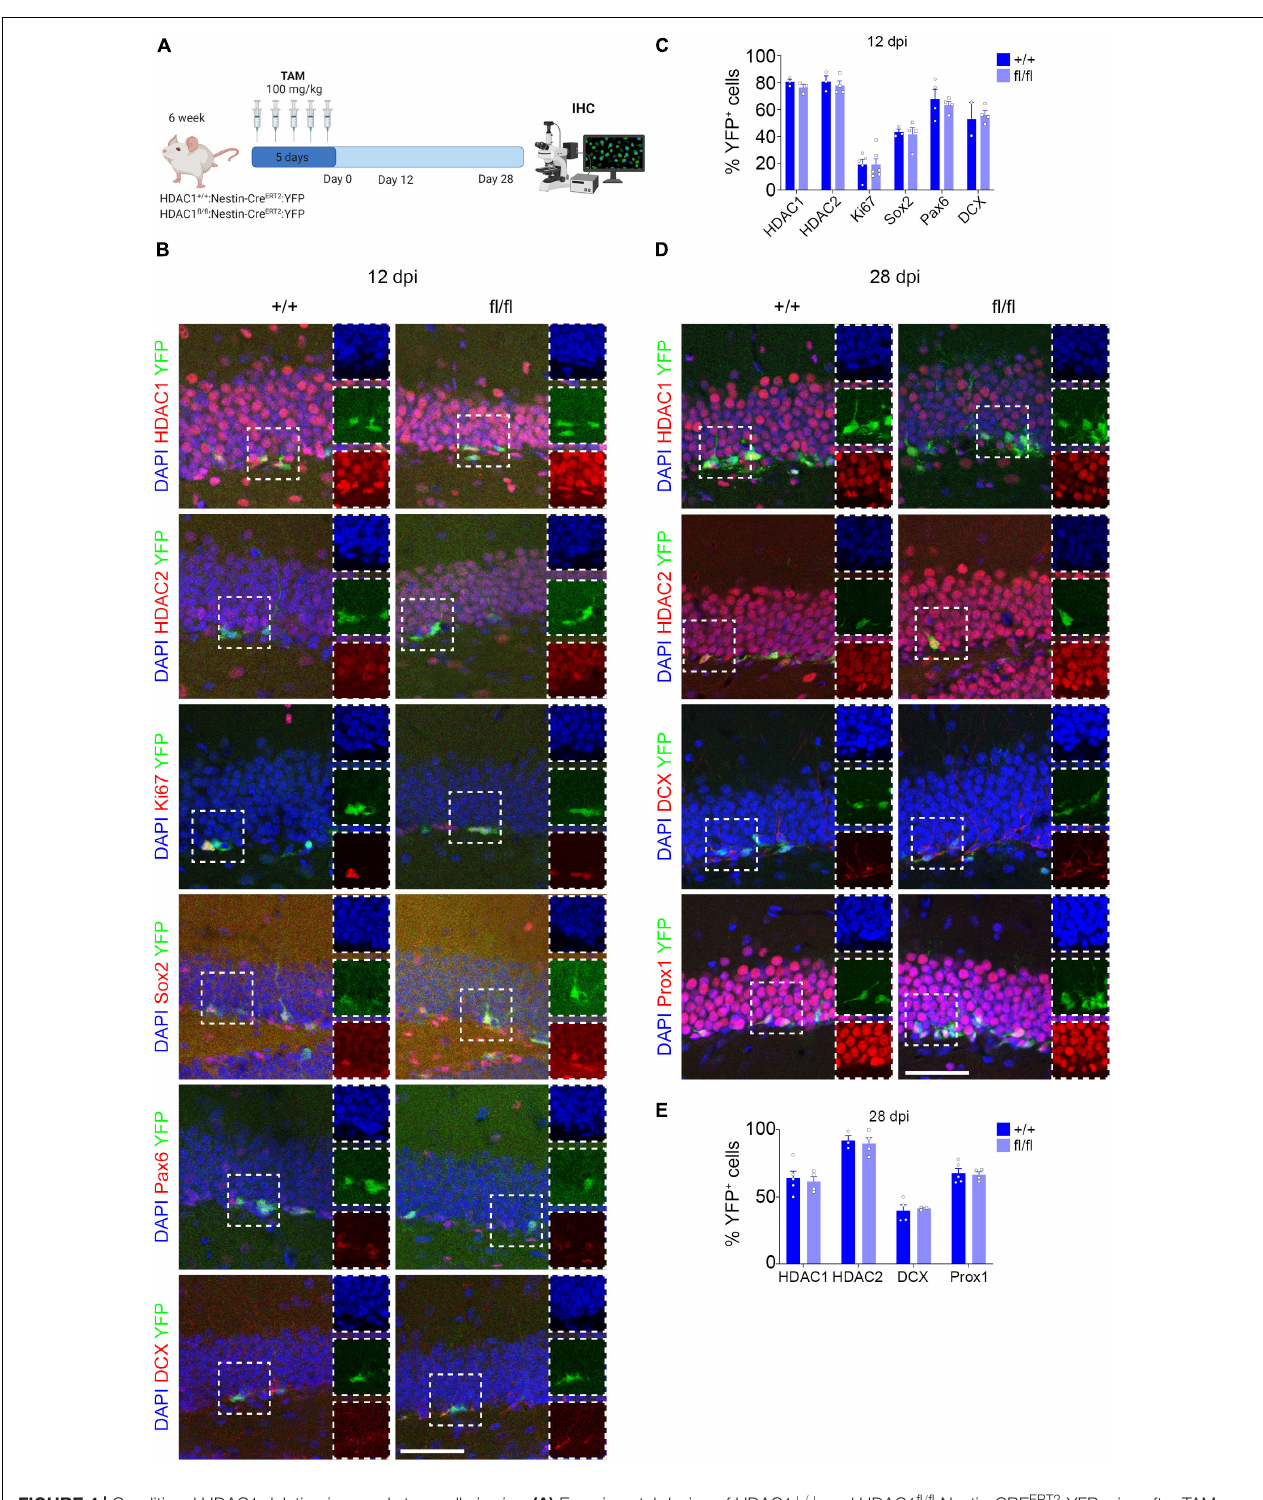
FIGURE 4 | Conditional HDAC1 deletion in neural stem cells in vivo . (A) Experimental design of HDAC1 + / + and HDAC1 fl / fl :Nestin-CRE ERT2 :YFP mice after TAM injections for 5 days. Mice were perfused and analyzed by IHC 12 and 28 dpi. (B) Representative images of HDAC1 + / + and HDAC1 fl / fl mice after 12 dpi immunostained against YFP, HDAC1, HDAC2, Ki67, Sox2, Pax6, and DCX; and stained with DAPI. (C) The graph shows the percentage of HDAC1 + , HDAC2 + , Ki67 + , Sox2 + , Pax6 + and DCX + out of the YFP + cells at 12 dpi. (D) Representative images of HDAC1 + / + and HDAC1 fl / fl mice after 28 dpi immunostained against YFP, HDAC1, HDAC2, DCX and Prox1; and stained with DAPI. (E) The graph shows the percentage of HDAC1 + , HDAC2 + , DCX + and Prox1 + out of the YFP + cells at 28 dpi. dpi = days post inyection, IHC = immunohistochemistry, TAM = tamoxifen. N = 2–5. Scale bar = 50.